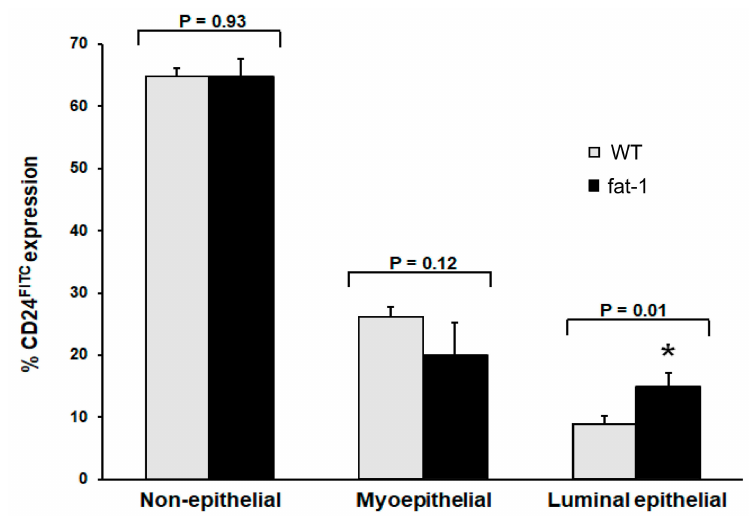
Figure 2. Percent CD24 FITC surface marker expression on mammary epithelial cells. Bars represent means plus SD and * identifies di ff erences ( p ≤ 0.05) between wildtype (WT) and fat-1 mice by Student’s t